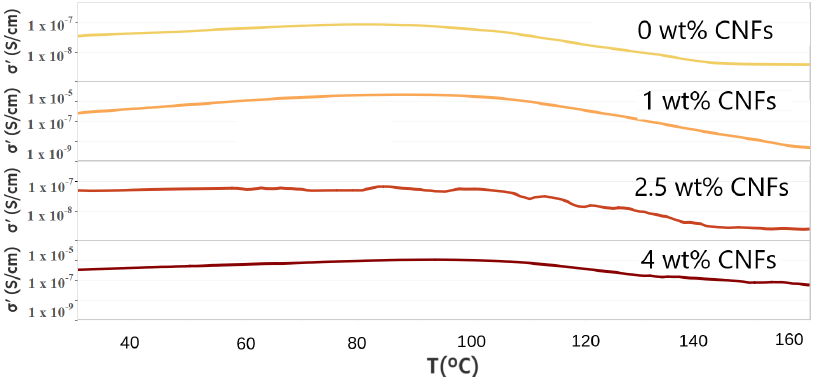
Figure 4. Real part of the dielectric complex function measured at 100 Hz as a function of